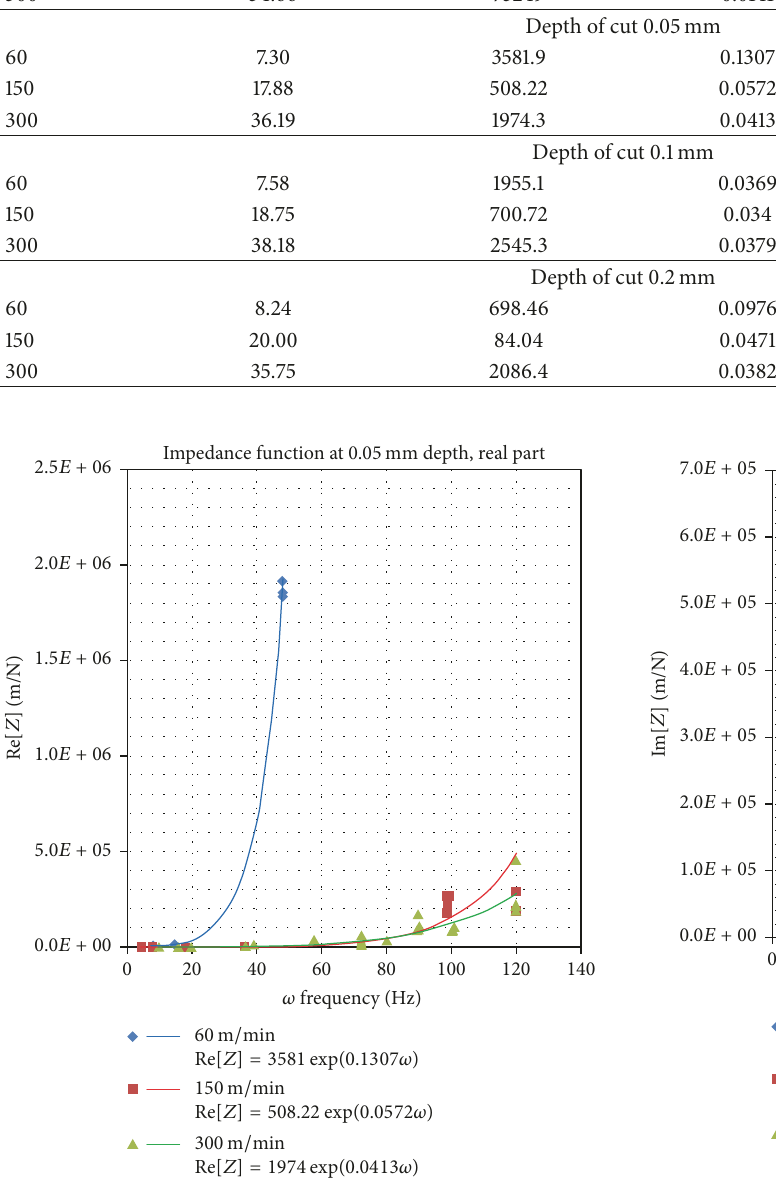
Figure 7: Real part of the impedance function, at 0.05 mm depth of cut, under 60, 150, and 300 m/min of cutting speed.